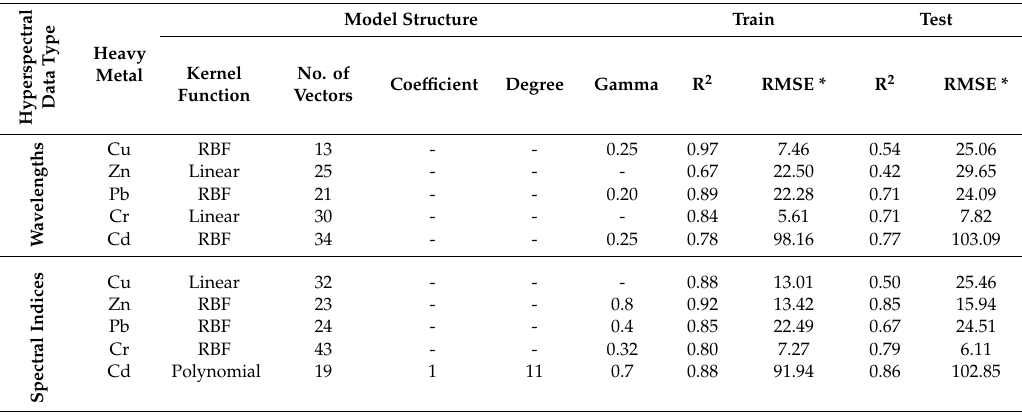
Table 3. Modelling and validation results of the best support vector machine (SVM) models based on optimal wavelengths and spectral indices for estimating heavy metal concentrations in grapevine leaves in training and testing sets. RBF: radial basis function.